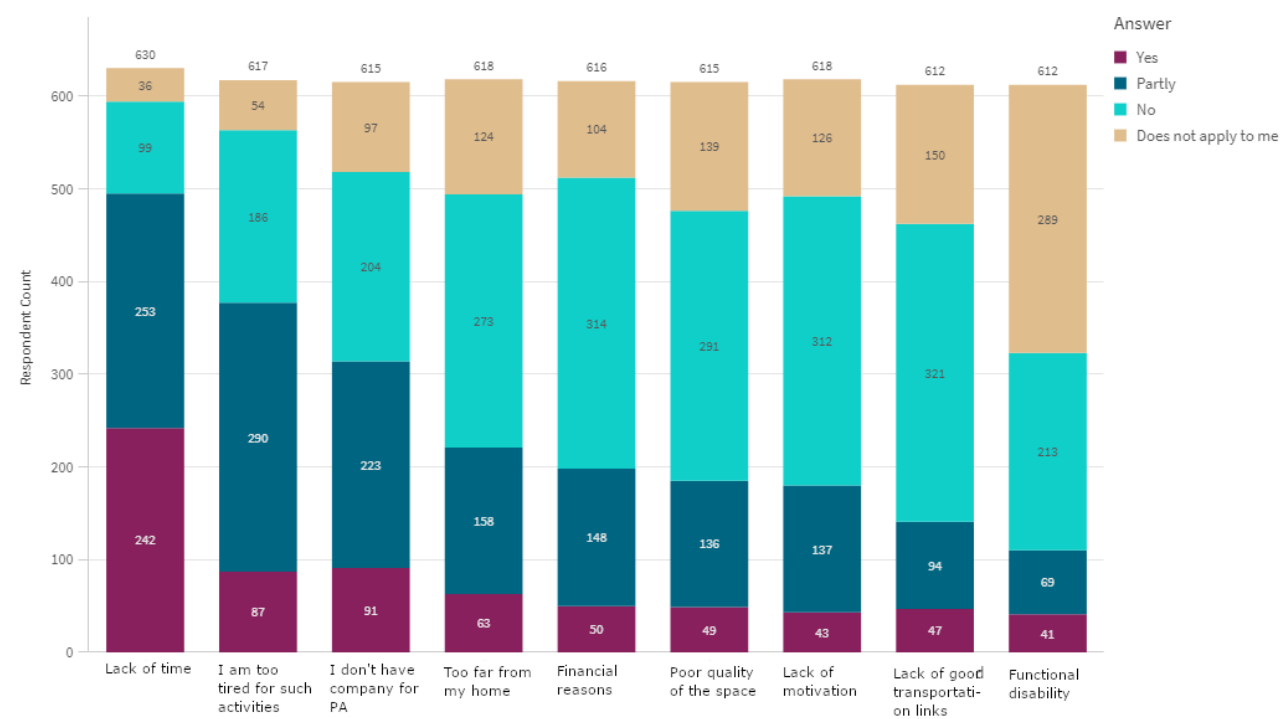
Figure 2. Reasons for Failing to Achieve Sufficient Physical Activity. Note: Missing values are excluded from the calculation.